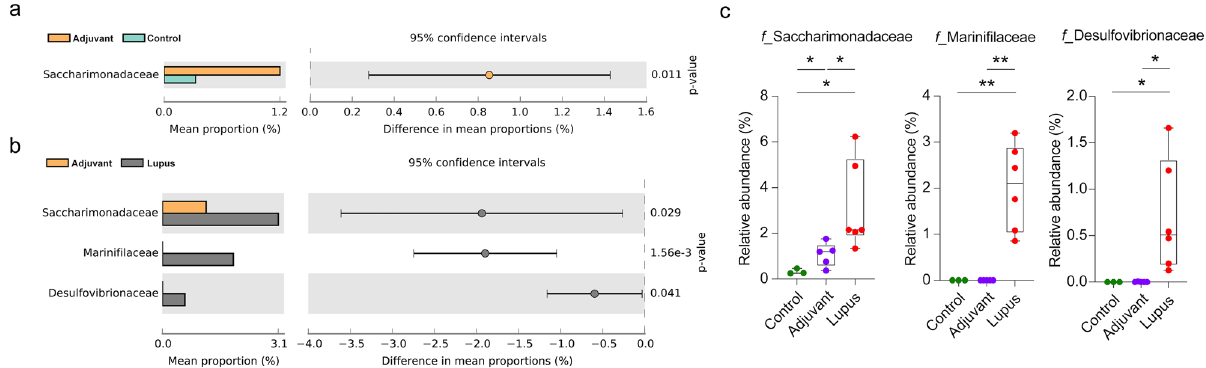
Figure 3. Relative abundance of fecal microbiota families. The abundances of family groups in the ( a ) adjuvant vs . control and ( b ) adjuvant vs . lupus groups analyzed by Welch’s t -test using STAMP software. ( c ) Families with higher abundances in the lupus compared with the adjuvant and control groups. * P < 0.05 and ** P <